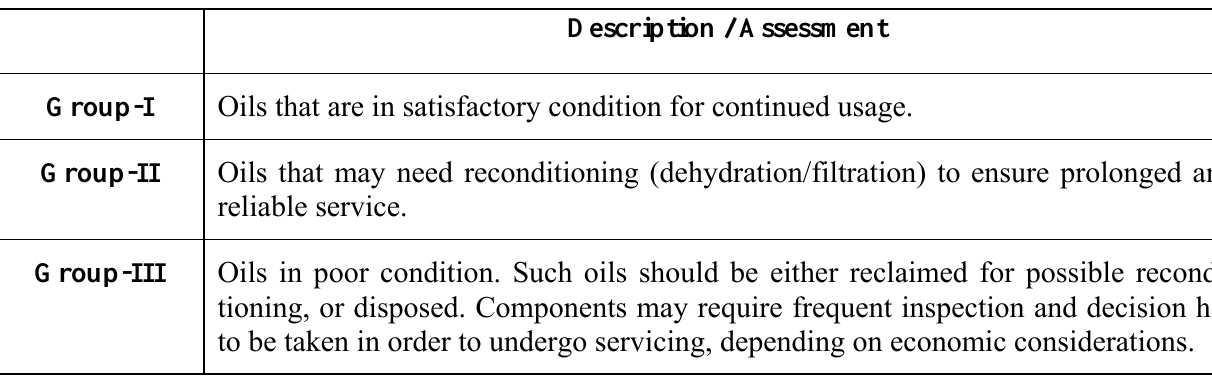
Table 2. Oil group classification in terms of permittivity characterization.